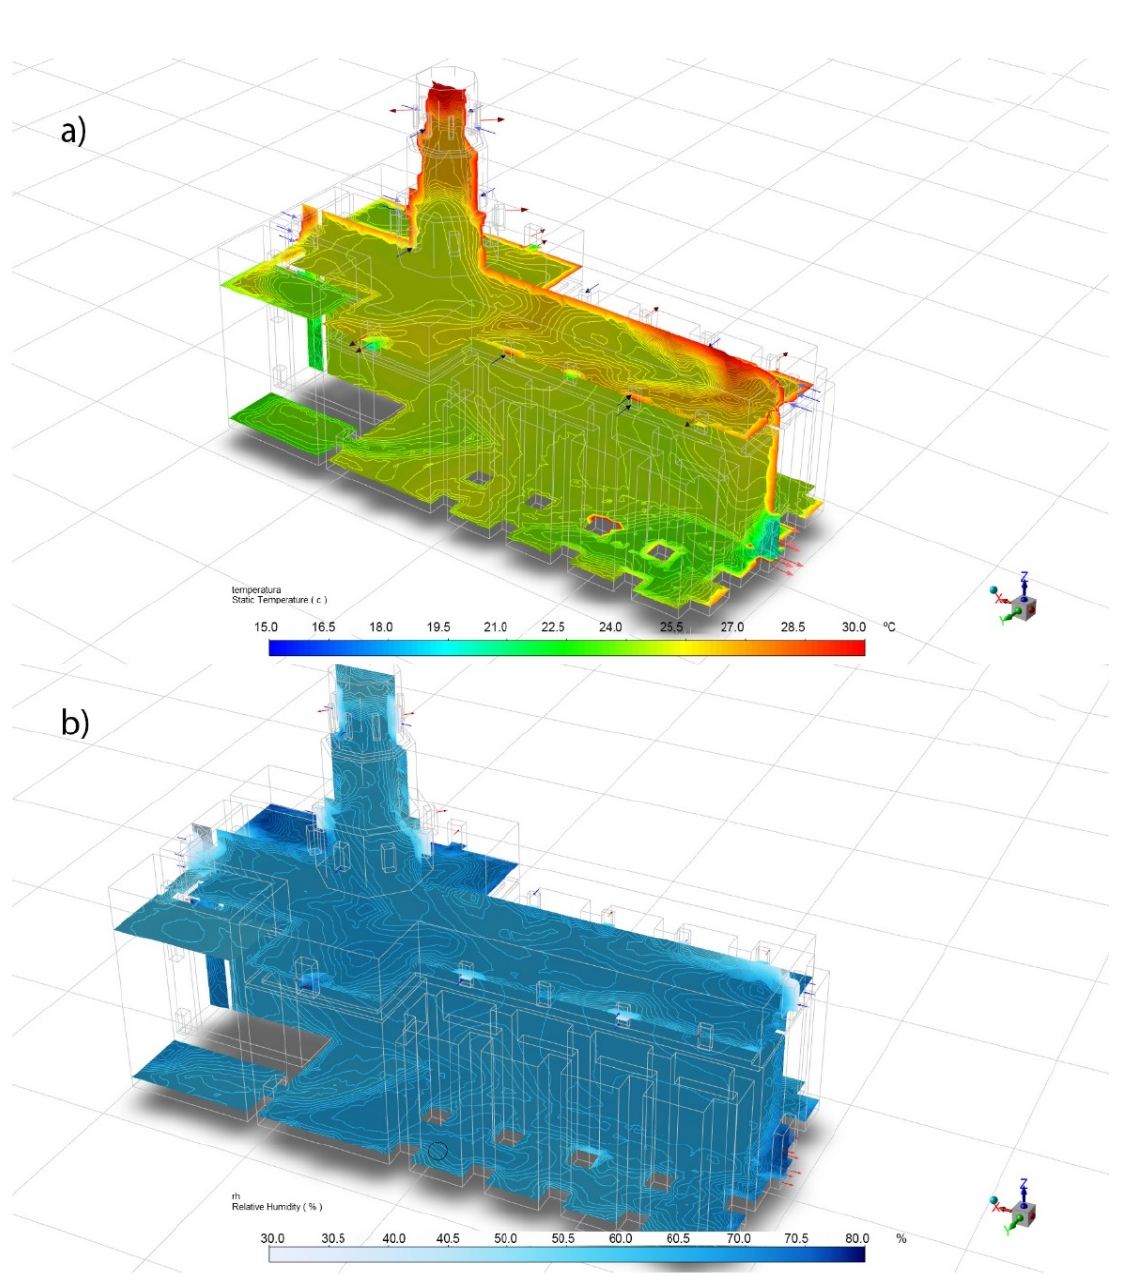
Figure 8. Summer CFD simulation perspective. ( a ) Temperatures and ( b ) relative humidity.